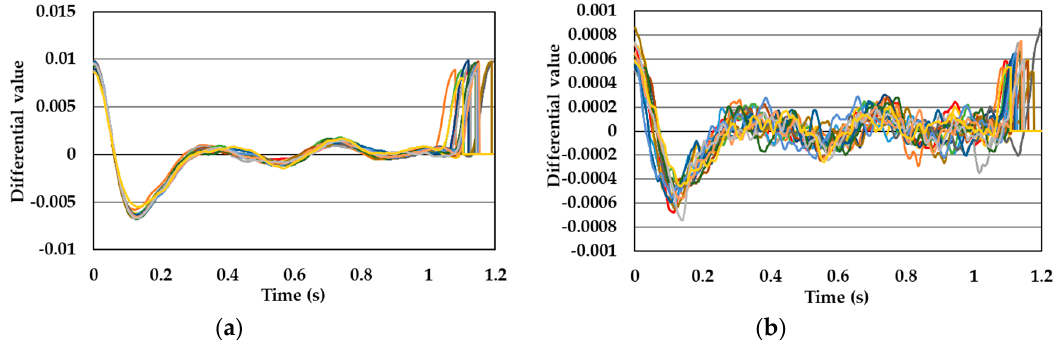
Figure 7. The single pulse wave signals of subject C: ( a ) POF-FBG sensor and ( b ) silica-FBG sensor.